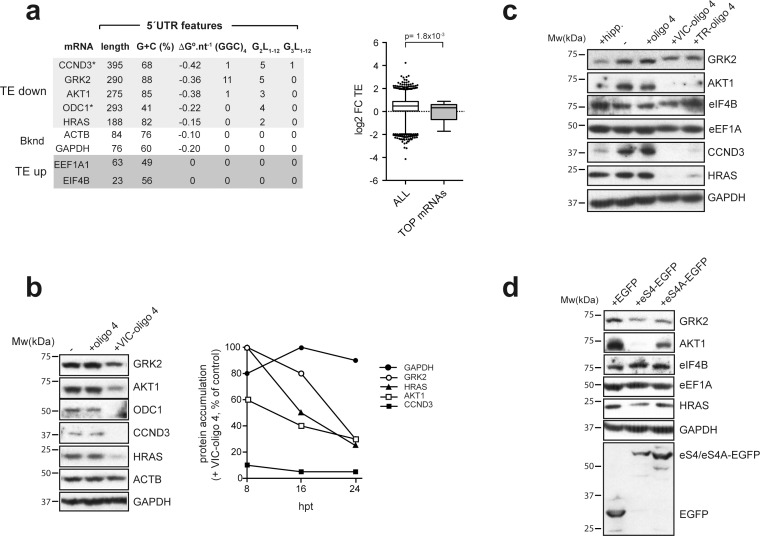
Effect of VIC–oligo 4 and TR–oligo 4 on the translation of mRNAs representative of the ‘TE down’ and ‘TE up’ groups.(a) 5′ UTR features of the representative mRNAs selected for the analysis, with structure stability per nucleotide shown, as well as the presence of (GGC/A)4 and G4s (G2L1–12 and G3L1–12) (left panel). The right panel shows a comparative analysis of log2 FC TE between all mRNAs and those TOP mRNAs that we detected in our dataset (36). p-value after U test is shown. (b) (Left) Western blot of the accumulated proteins at 24 hr post-transfection (hpt) of the indicated oligos in HEK293T cells. (Right) Time course of protein accumulation at 8 hr, 16 hr and 24 hr post-transfection (hpt) of VIC–oligo 4, with data represented as percentage of the control values (+ oligo 4). (c) Comparative effect of hippuristanol (hipp), VIC–oligo 4 and TR–oligo 4 on the indicated protein levels. Data were analyzed by western blot at 24 hpt with the indicated oligonucleotides; hipp was used at 1 μM. (d) Effect of eS4–EGFP and eS4A–EGFP overexpression on the accumulation of some representative proteins. HEK293T cells were transfected with plasmids expressing the indicated proteins and cell extracts were analyzed by western blot at 48 hpt.